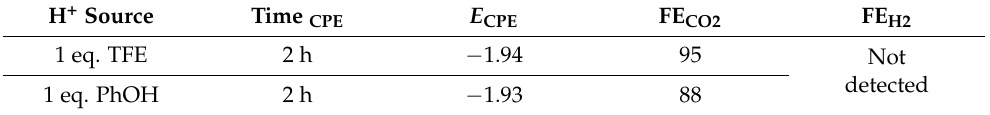
detected 1 eq. PhOH 2 h − 1.93